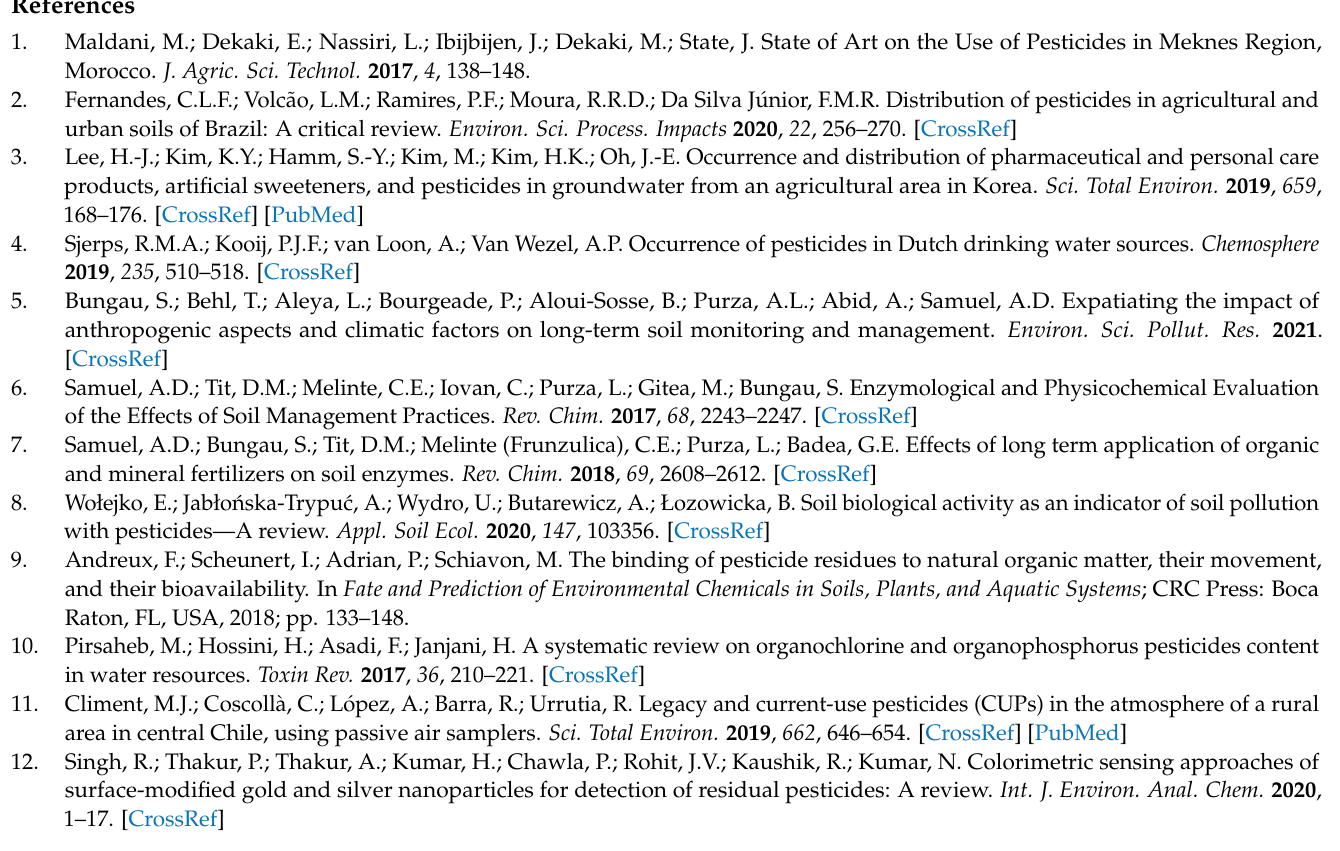
quota method; Table S2: Knowledge and decision-making mechanism related to pesticide use prac- tices, Table S3: Behavior of farmers for storing and disposing of pesticides, Table S4: Precautionary measure of the farmers surveyed, Table S5: Awareness of the risks of pesticides on the environment and human